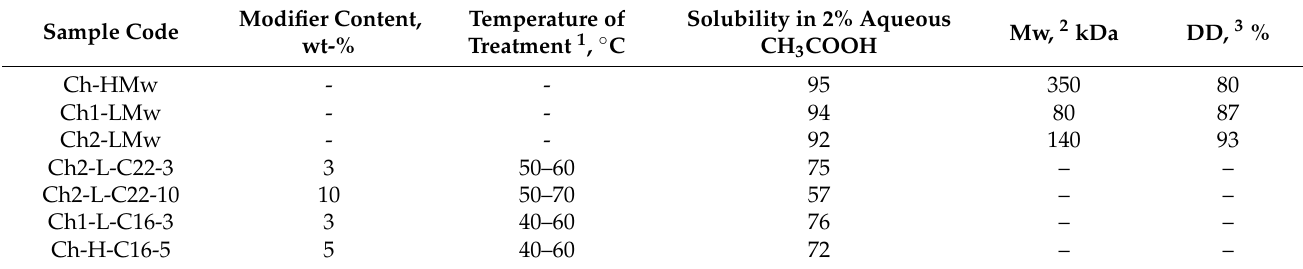
Table 1. Conditions for obtaining samples and their